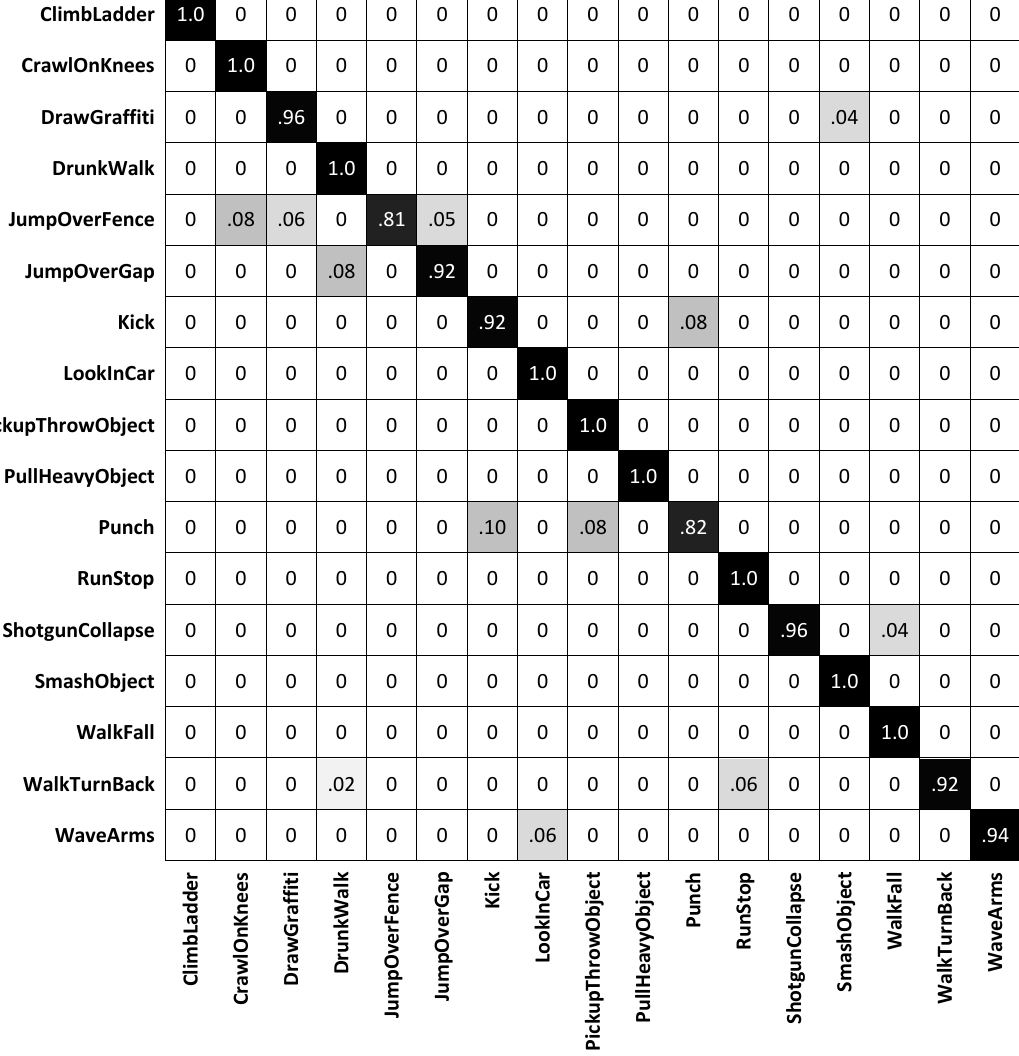
Figure 11. The confusion matrix of the recognition output on the MuHAVi dataset.